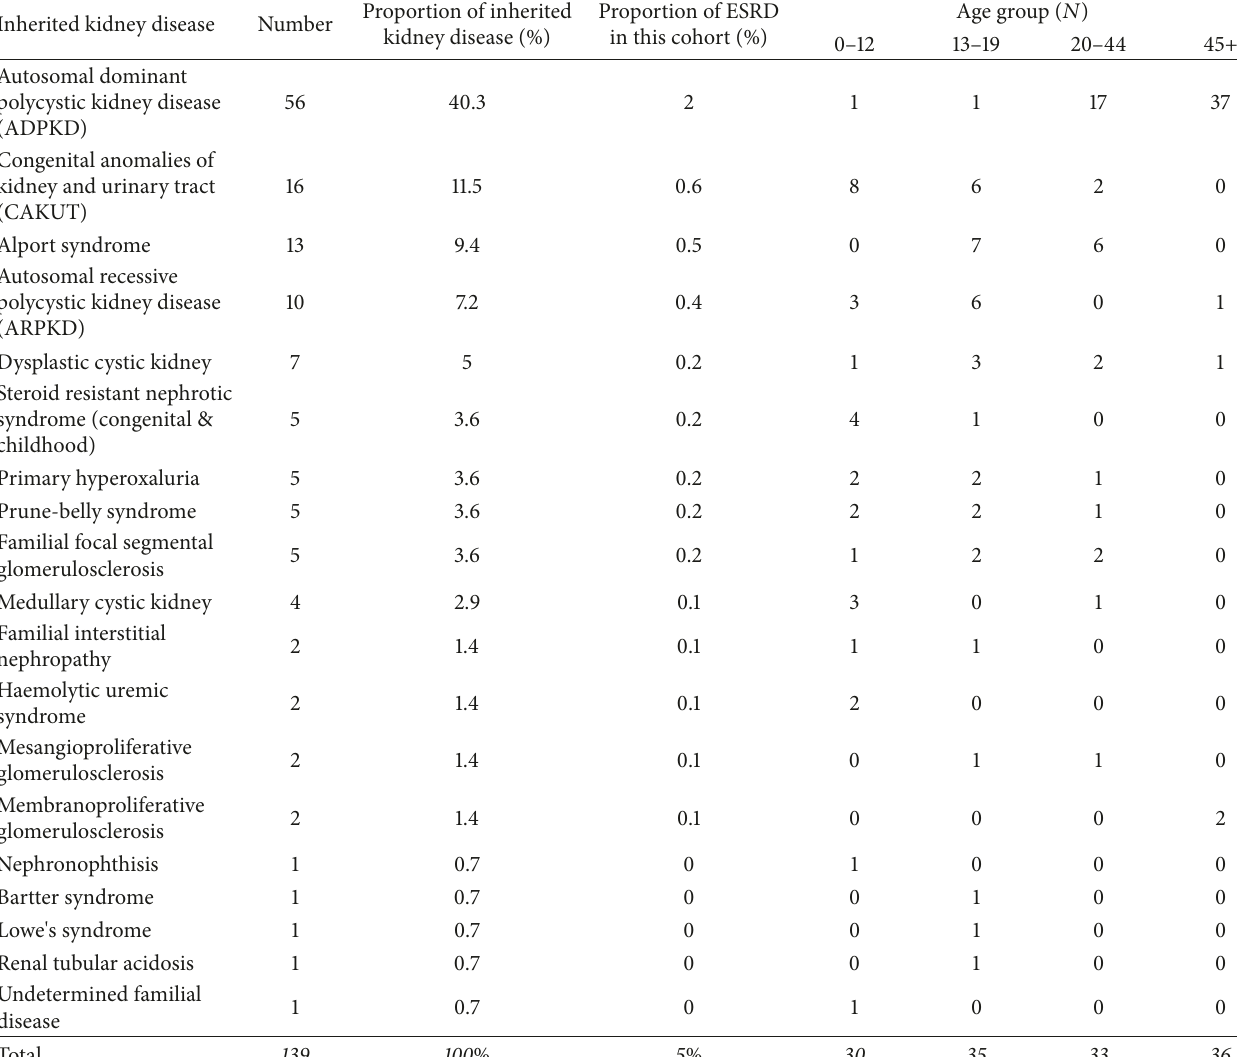
Table 5: Inherited kidney diseases in ESKD population